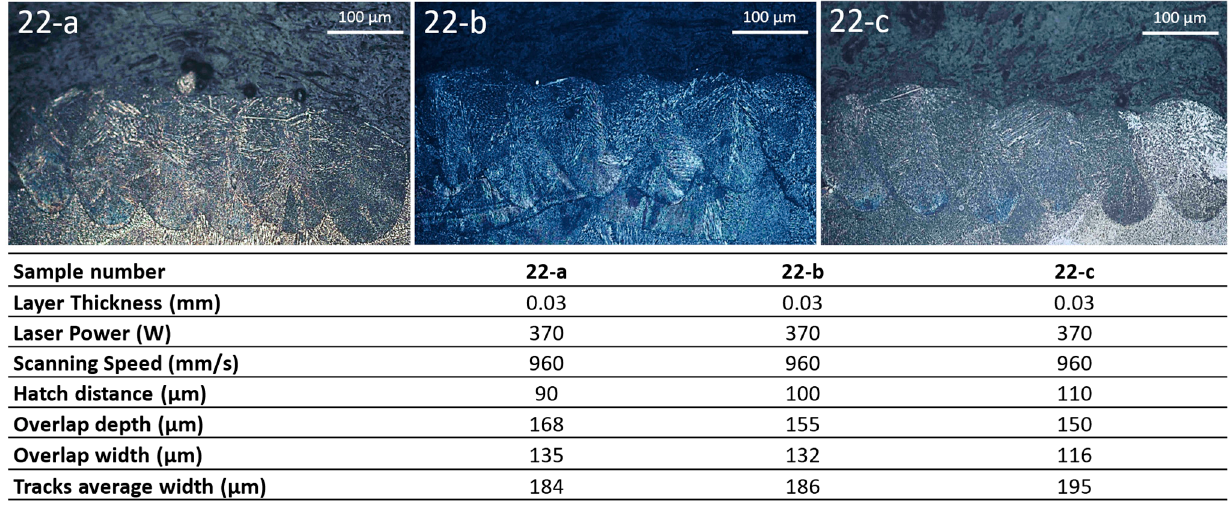
Figure 16. Effect of variation of hatch distance on overlap region dimensions.